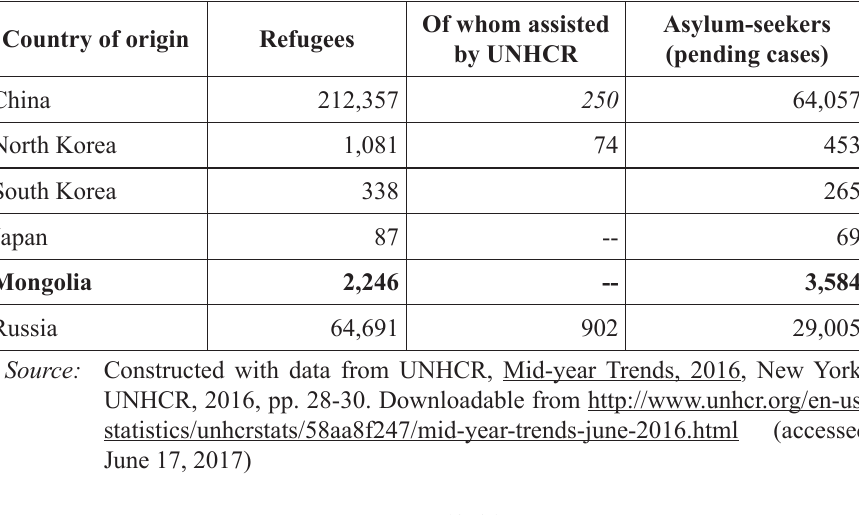
Table 3. Refugees and asylum seekers by country/territory of origin, mid-2016 Country of